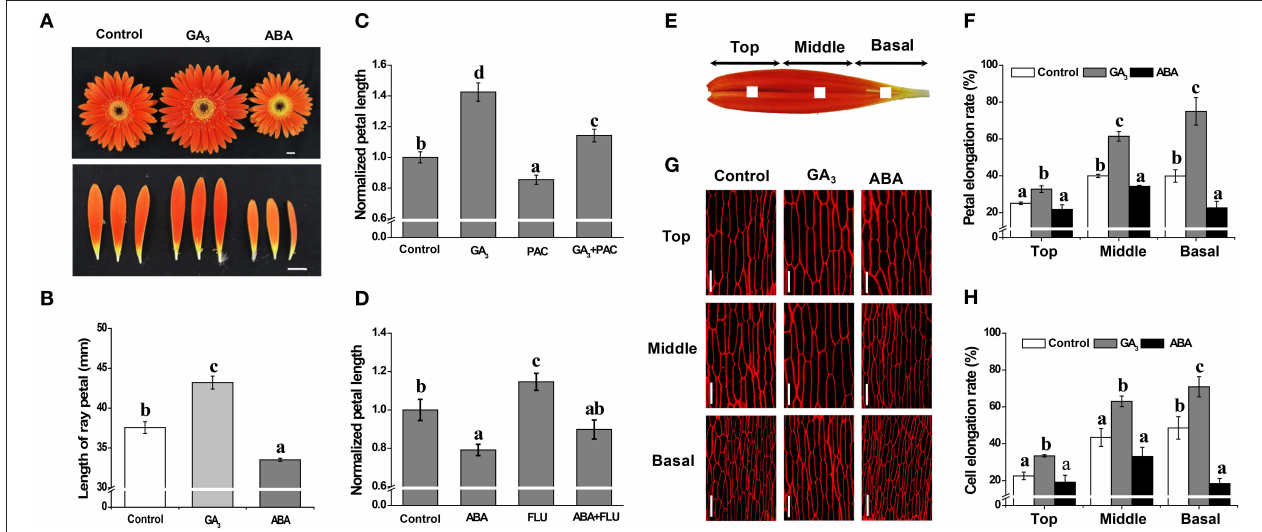
for which the control petal length was set as 1. One mm 2 blocks at the center of the top, middle or basal regions of the petal are indicated in (E) . Detached petals treated with Control, 10 µ M GA 3 or 50 µ M ABA for 9 days were used for morphological characterization of adaxial epidermal cell using a confocal microscope (G) and measurement of elongation rate of each petal region ( F , n = 10 ) or cell ( H , n > 100). Three biological replicates were performed for each measurement. Values are given as mean ± SE. Letters above the bars indicate significant differences between the respective values ( p < 0 . 05 ). Scale bar represents 1cm (A) or 50 µ m (G)